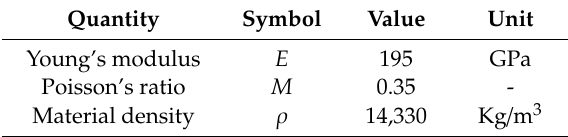
Table 1. Material parameters for specimen simulation